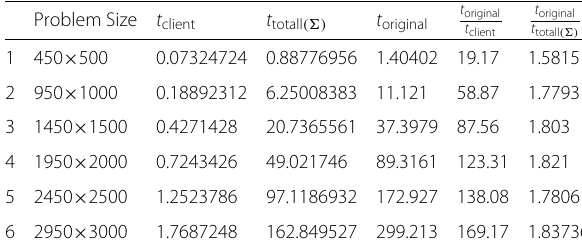
Table 6 Ax ≡ b mod 12289 with parameters f ( m ) = m − 1, g ( n ) = n − 1 (Continue with Table 5,unit:s) Problem Size t client